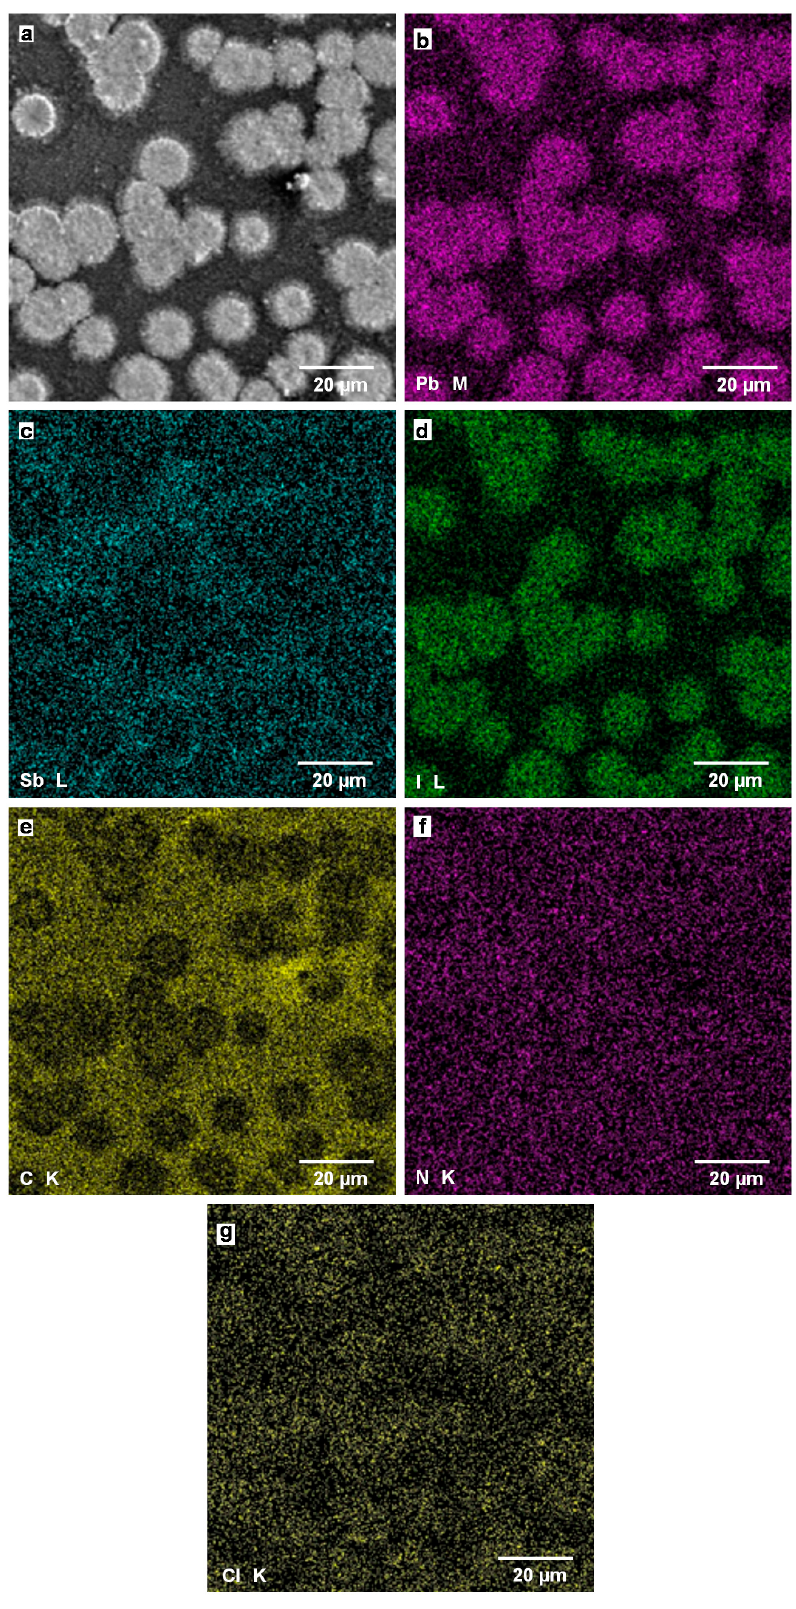
Figure 8. ( a ) SEM image of CH 3 NH 3 Pb(Sb)I 3 (Cl) cell with additives of SbI 3 with PbCl 2 ; Elemental mapping images of ( b ) Pb M line, ( c ) Sb L line, ( d ) I L line, ( e ) C K line, ( f ) N K line, and ( g ) Cl K line.